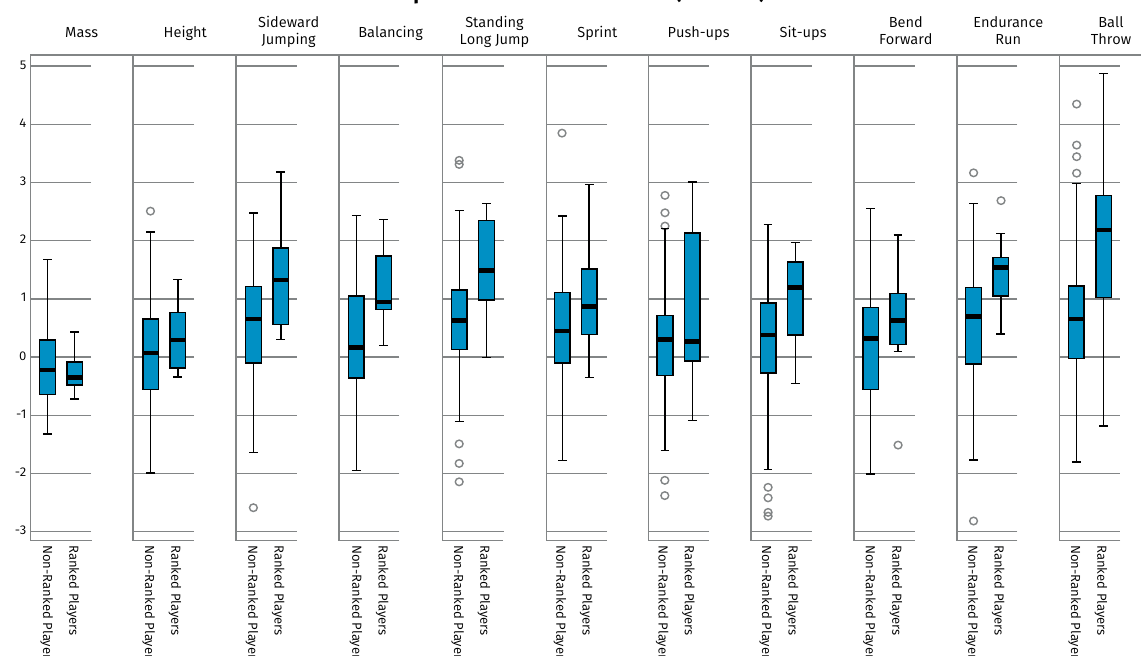
Apart from the forward bends, no significant results can be seen for the correlations of tennis ranking success with body height or body mass (Table 3). All other test values achieved significant correlations, mostly in the moderate range. The ball throw reaches the highest correlation value with r = .360, followed by the standing long jump ( r = .287), and the endurance run ( r = .296). However, these two values cannot be considered a moderate result. Also, all other test values have small correlation effects. Boxplots for the U9 test results (z-values)